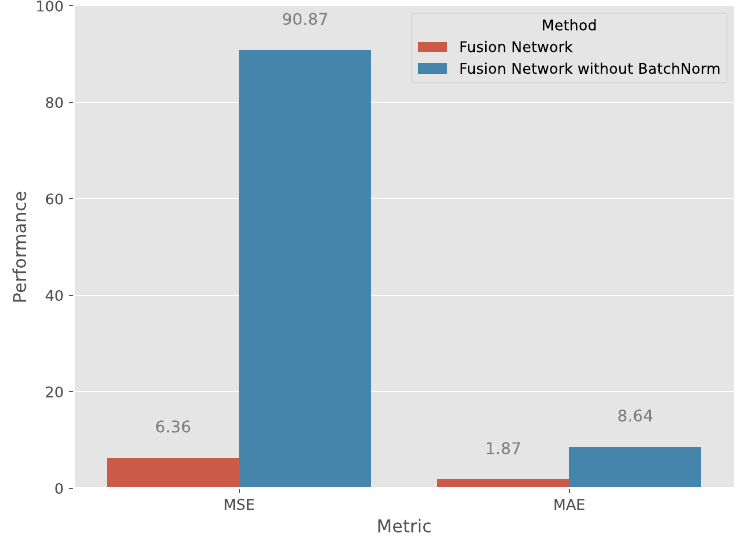
Figure 9. The impact of batch normalization, where a lower value is